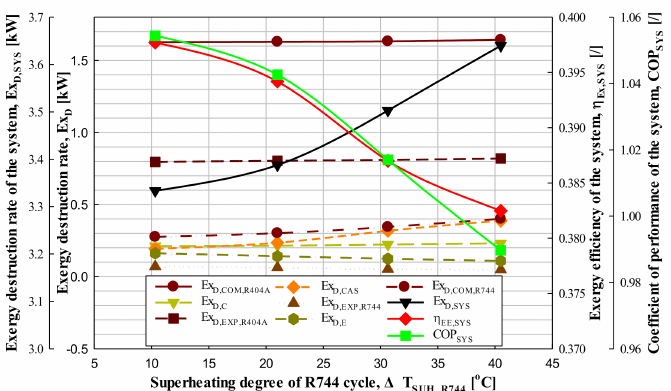
Figure 6. Exergy destruction rate, exergy efficiency and COP of the CRS with respect to superheating degree of R744